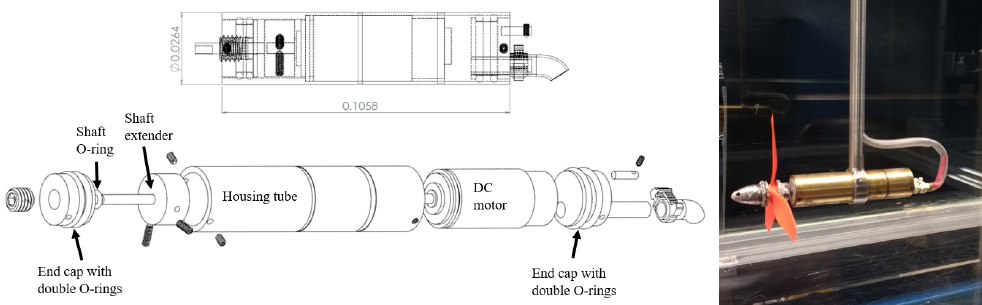
Figure 6. CAD drawing of the model turbine and a picture of one fully assembled. Dimensions are in meters.